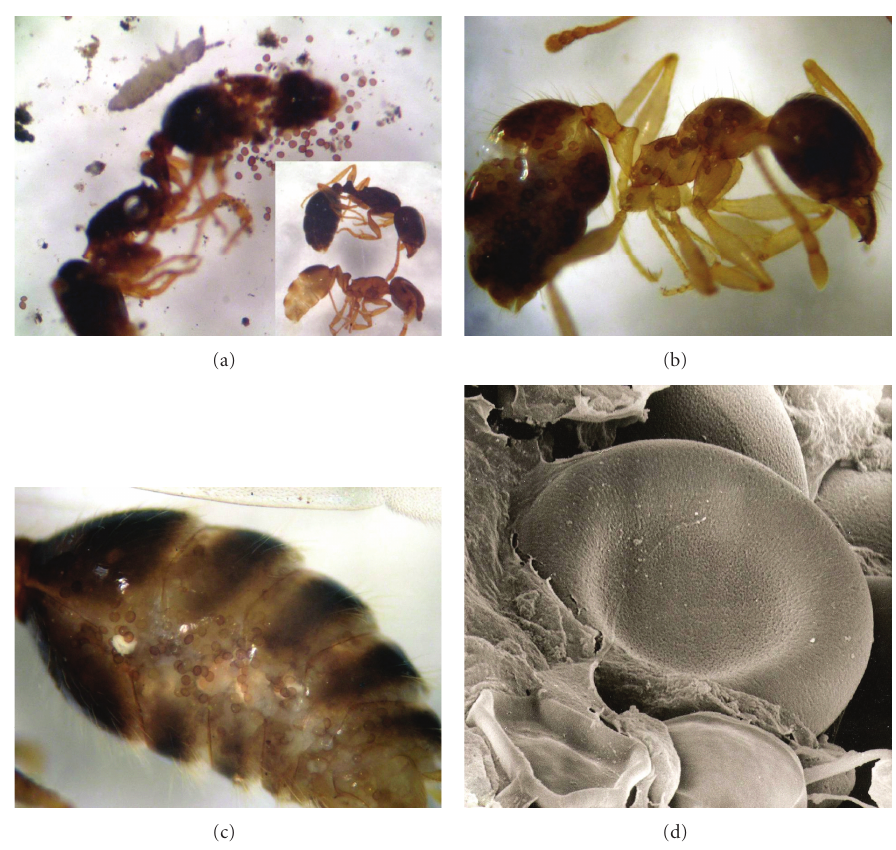
Figure 7: (a) Myrmicinosporidium mature spores inside workers Tetramorium semilaeve (inset: darker, infested worker, and normally coloured worker); (b) Pheidole pallidula with many spores on thorax, coxae, and gaster; (c) gaster of a male Pheidole pallidula with spores; (d) SEM image of a spore, showing the artifactual characteristic doughnout shaped form resulting from the alcohol fixation.